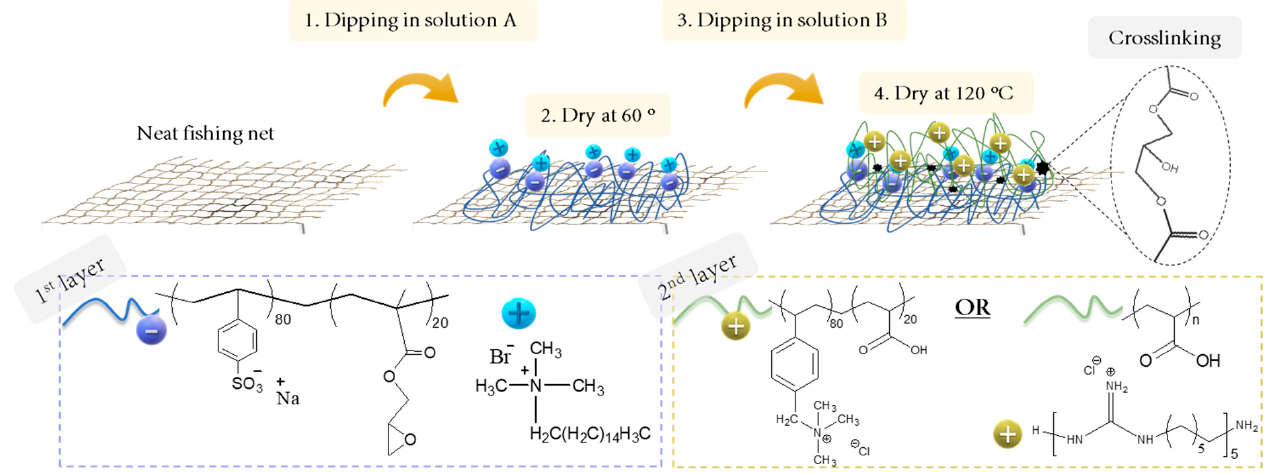
Table 2. Coated nets with P(SSAmC 16 ‐ co ‐ GMA20)/P(VBCTMAM ‐ co ‐ AA20), P(SSAmC 16 ‐ co ‐